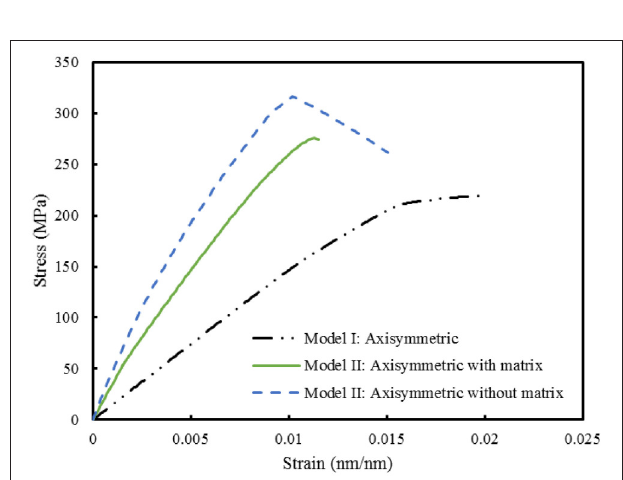
Note that the axisymmetry implies a 360 degree rotation about the axis of the fibril. Thus, the axisymmetric case is a good representation of the 3D geometry for the ML case since that model involves concentric cylinders which encircle a collagen fibril. The staggered mineral arrangement model, in